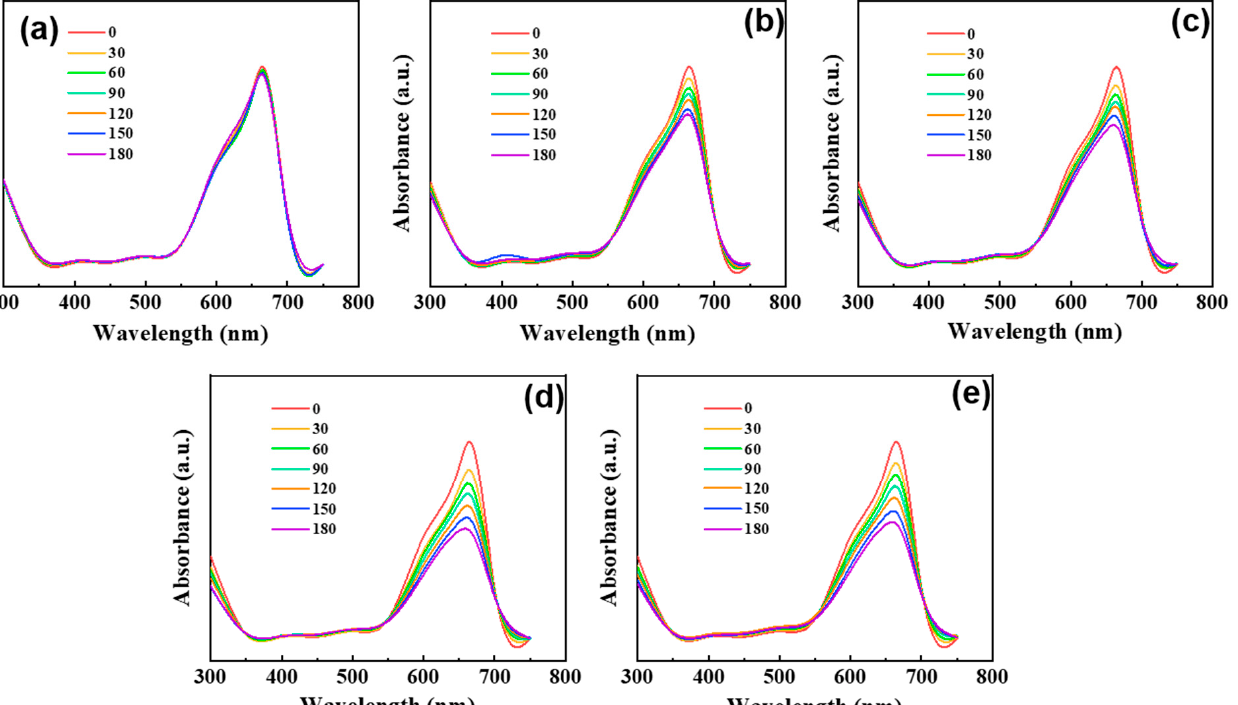
Figure 5. Absorption spectral pattern of ( a ) control and EY during photocatalytic degradation pro- cess in the presence of LC-ZnO/OF under visible light irradiation ( b – e ).